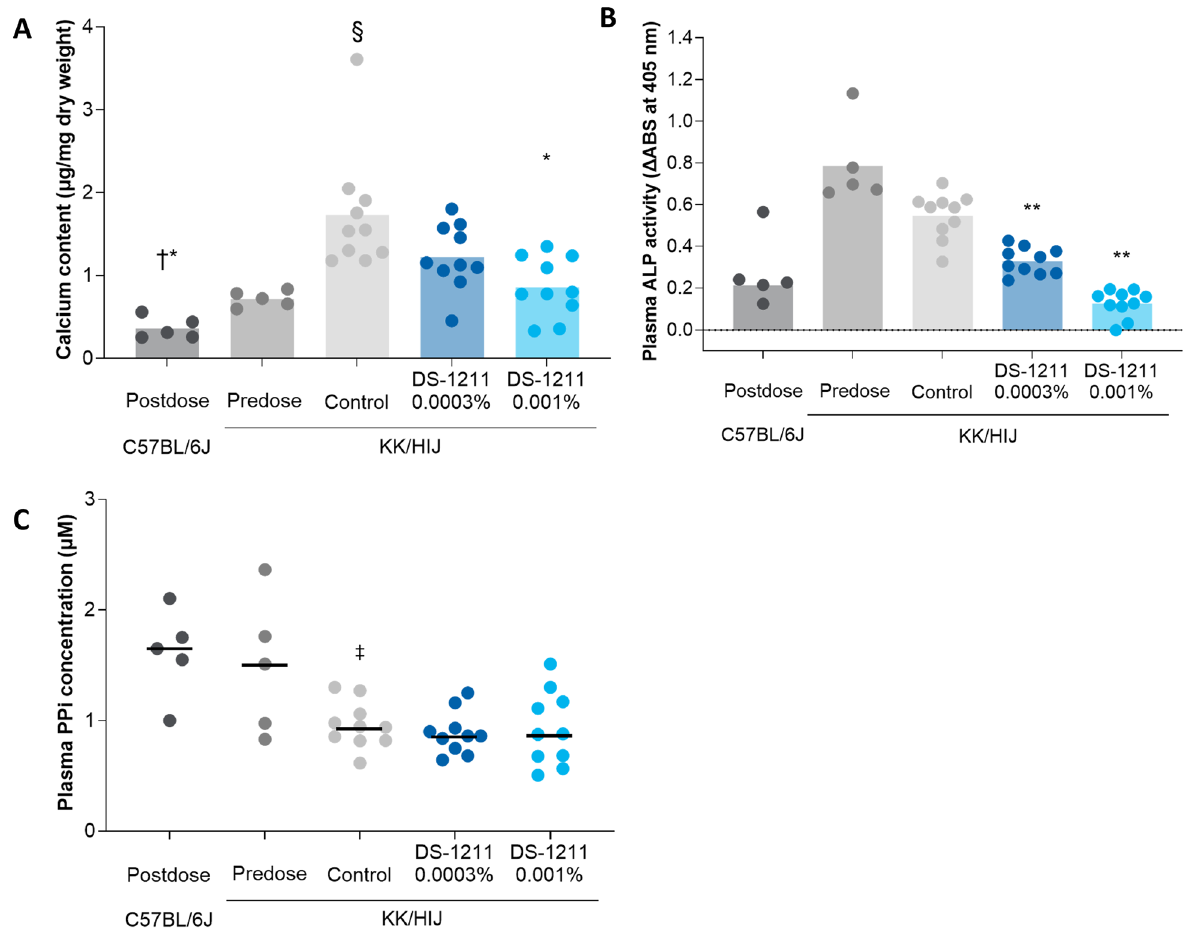
Figure 1. Calcium content (mean) ( A ), plasma ALP activity (mean) ( B ), and plasma PPi concentration (median) ( C ) in KK/HlJ and C57BL/6J mice before (KK/HlJ mice only) and after DS-1211 administration. * P < 0.005 versus control group; † P < 0.005 versus pre-administration group; § P < 0.01 versus pre-administration group; ** P < 0.0001 versus control group; ‡ P < 0.005 versus C57BL/6J group. ABS, absorbance; ALP, alkaline phosphatase; PPi, dry weight) than the postdose ABCC6 -/- control mice ( P = 0.0005). ABCC6 -/- mice receiving DS-1211 3 mg/kg and DS-1211 10 mg/kg had dose-dependent reduction in vibrissae calcification progression compared with the vehicle-treated ABCC6 -/- control group ( P < 0.0001). Calcium content measurements in the DS-1211 3-mg/ kg and DS-1211 10-mg/kg groups after dosing were 1.65 ± 0.15 µg/mg dry weight and 1.43 ± 0.11 µg/mg dry weight, respectively ( P < 0.0001 and P < 0.0001 vs. the ABCC6 -/- control group, respectively). Representative results from the microCT imaging of vibrissae postdosing are shown in Fig. 3. More calcium deposits were observed around vibrissae in the ABCC6 -/- control group compared with the C57BL/6J control group. Compared with the ABCC6 -/- control group, fewer calcium deposits were observed around vibrissae in the DS-1211 3 mg/kg and DS-1211 10 mg/kg groups. Both DS-1211 3 mg/kg and DS-1211 10 mg/kg led to significant, dose-dependent decreases in plasma ALP activity compared with the ABCC6 -/- control group ( P < 0.0001; Fig. 2B). Plasma ALP activity (mean ± SE) was inhibited 89.4% with DS-1211 3 mg/kg 30 min after oral dose administration compared with the ABCC6 -/- control (0.05 ± 0.01 vs. 0.42 ± 0.05, respectively; P < 0.0001); 94.2% plasma ALP inhibition was observed with DS-1211 10 mg/kg (0.02 ± 0.01). DS-1211 led to numerical increases in plasma PPi ( P = 0.226) and statistically significant dose-dependent increases in plasma PLP ( P < 0.0001) concentrations 30 min after administration in ABCC6 -/- mice, as shown in Fig. 2C,D. In the predose ABCC6 -/- control group, median plasma PPi concentration (0.44 μM) was significantly lower than in the predose C57BL/6J group (1.54 μM, P = 0.008). After dosing, plasma PPi concentration remained lower in the ABCC6 -/- control group compared with the C57BL/6J group ( P = 0.0007). Median plasma PPi con- centration was significantly higher in both the DS-1211 3 mg/kg (0.86 μM) and DS-1211 10 mg/kg (0.73 μM) groups than in the postdose ABCC6 -/- control group (0.46 μM; P = 0.008 and P = 0.036, respectively; Fig. 2C). Plasma PLP concentration (mean ± SE) was significantly higher in both the DS-1211 3 mg/kg (469.3 ± 26.1 ng/ mL) and DS-1211 10 mg/kg (497.5 ± 24.5 ng/mL) groups than in the postdose vehicle-treated ABCC6 -/- control group (45.8 ± 5.7 ng/mL; P < 0.0001 and P < 0.0001, respectively; Fig. 2D).